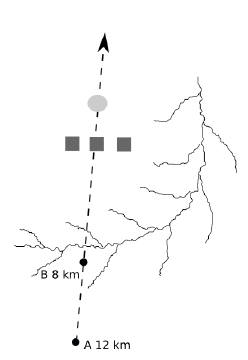
Figure 9: Scenario 3 for survey question